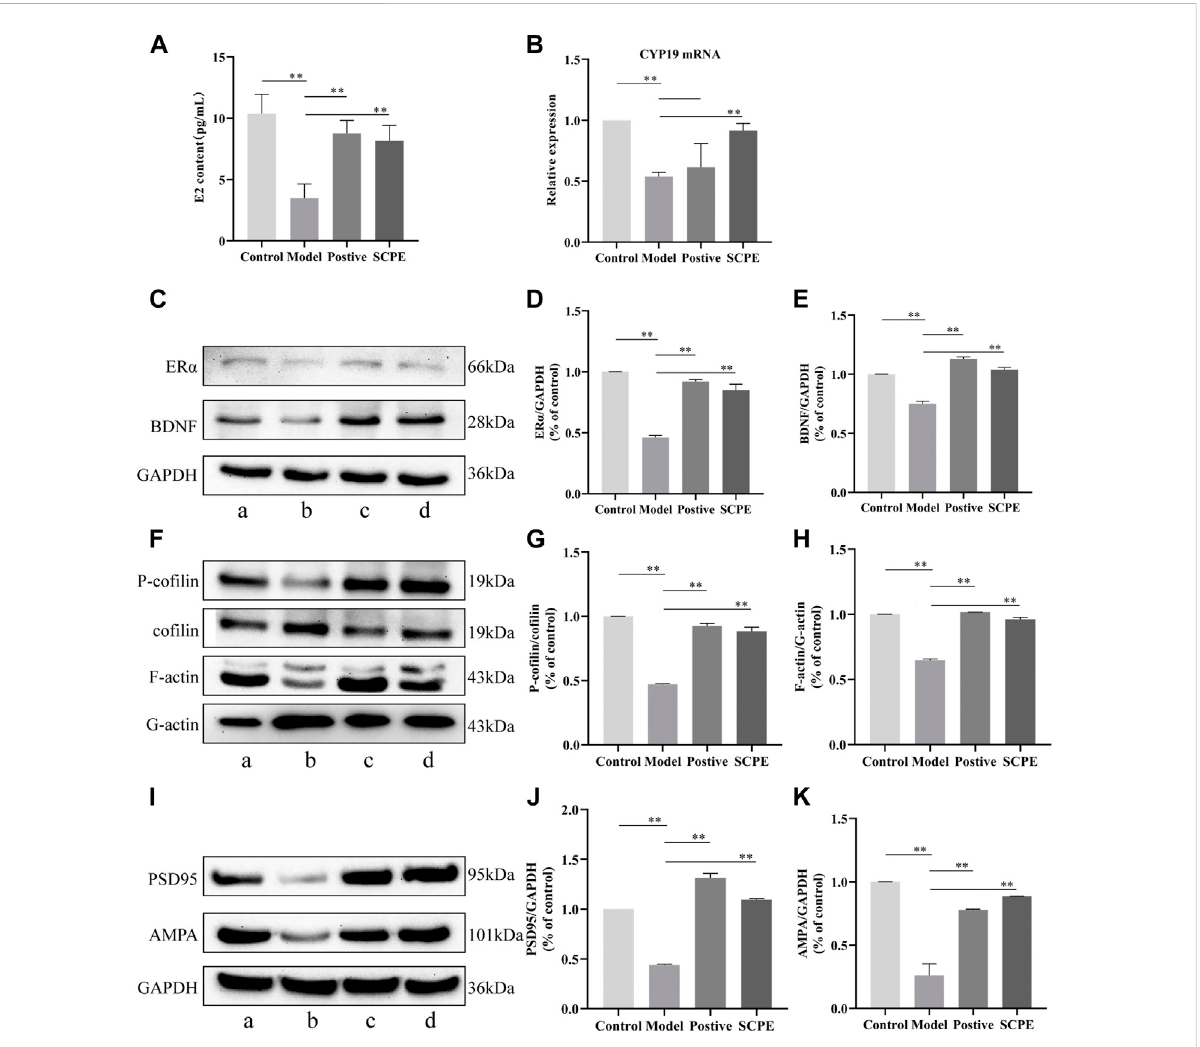
FIGURE 5 EffectsofSCPEonestrogenandsynapticplasticityinthehippocampus. (A) DeterminationofE2contentinmousehippocampusbyELISAkit. (B) RT-qPCR analysis of CYP19 mRNA expression in mouse hippocampus. (C) (F) (I) Proteins in the mouse hippocampus were analyzed by Western blot.a:Controlgroup; (B) Model group; (C) Postivegroup; (D) SCPEgroup. (D,E) (G,H)(J,K) Relativeexpression levelsanalyzed with ImageJsoftware areshown.Datain (A – K) presentedasthemean±SDofthreeindependentexperiments.* p < 0.05,** p < 0.01comparedwithindicatedgroups.